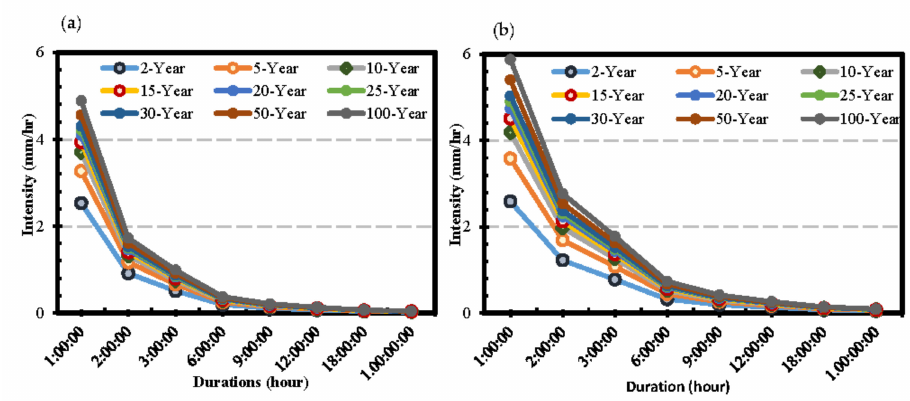
Figure 7. ( a ). Observed and downscaled daily precipitation from the MIROC6 Model. ( b ). Observed and downscaled daily precipitation from the CMCC-ESM2 Model.